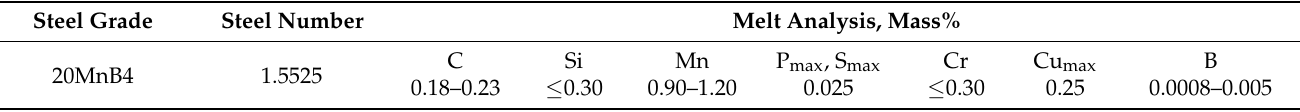
Table 1. Chemical composition of 20MnB4 steel